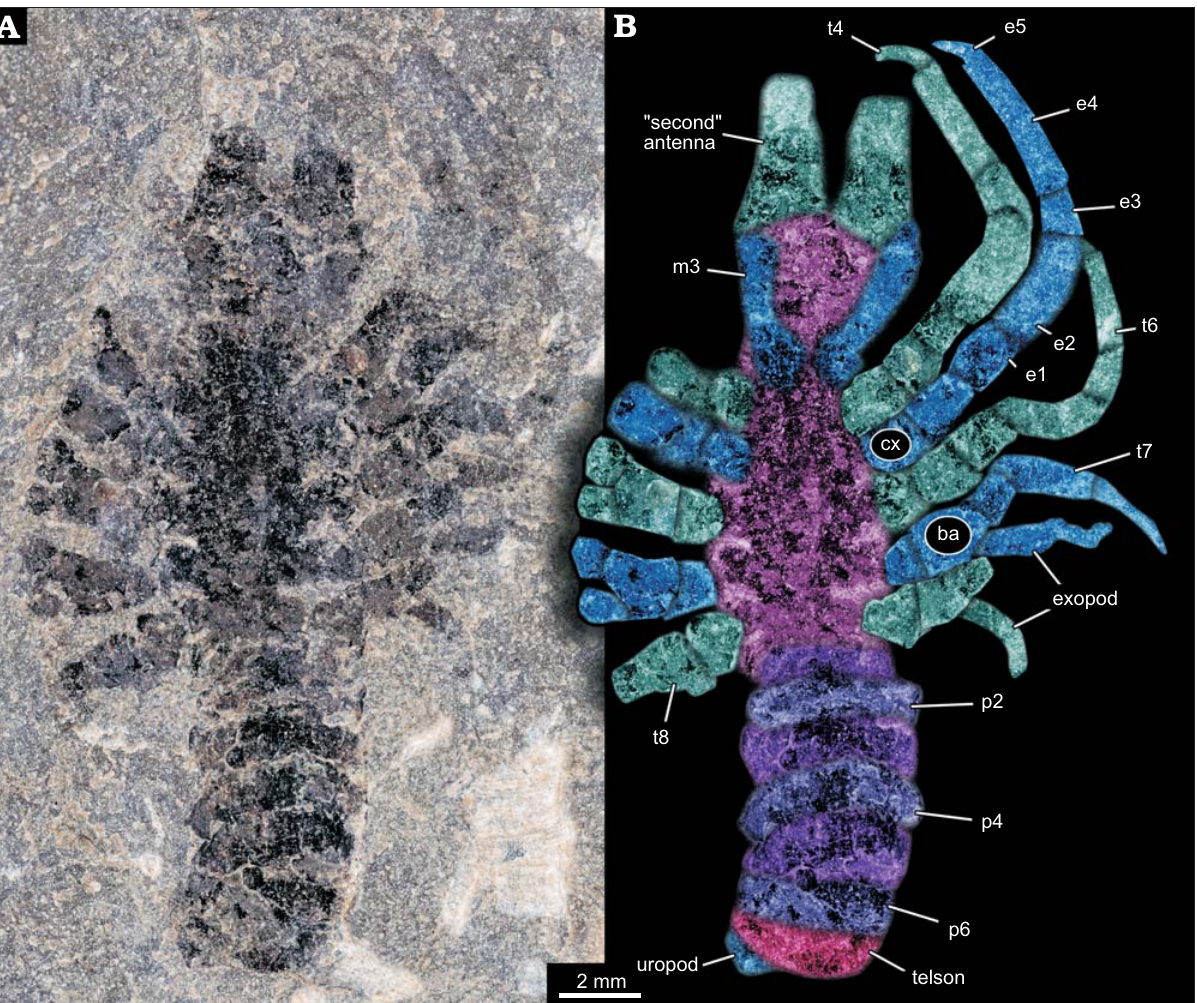
Fig. 1. Larva of Achelata gen. et sp. indet. (SMNS 70449), Toarcian, Lower Jurassic, Gomaringen, Southern Germany. A . Composite microscopic pho- tograph under cross-polarised light. B . Colour-marked photograph indicating the visible structures. Abbreviations: ba, basipod; cx, coxa; e1–5, endopod element 1–5; m3, maxilliped 3; p2–6, pleon segment 2–6; t4–8, thoracic appendages 4–8 (“pereiopods”